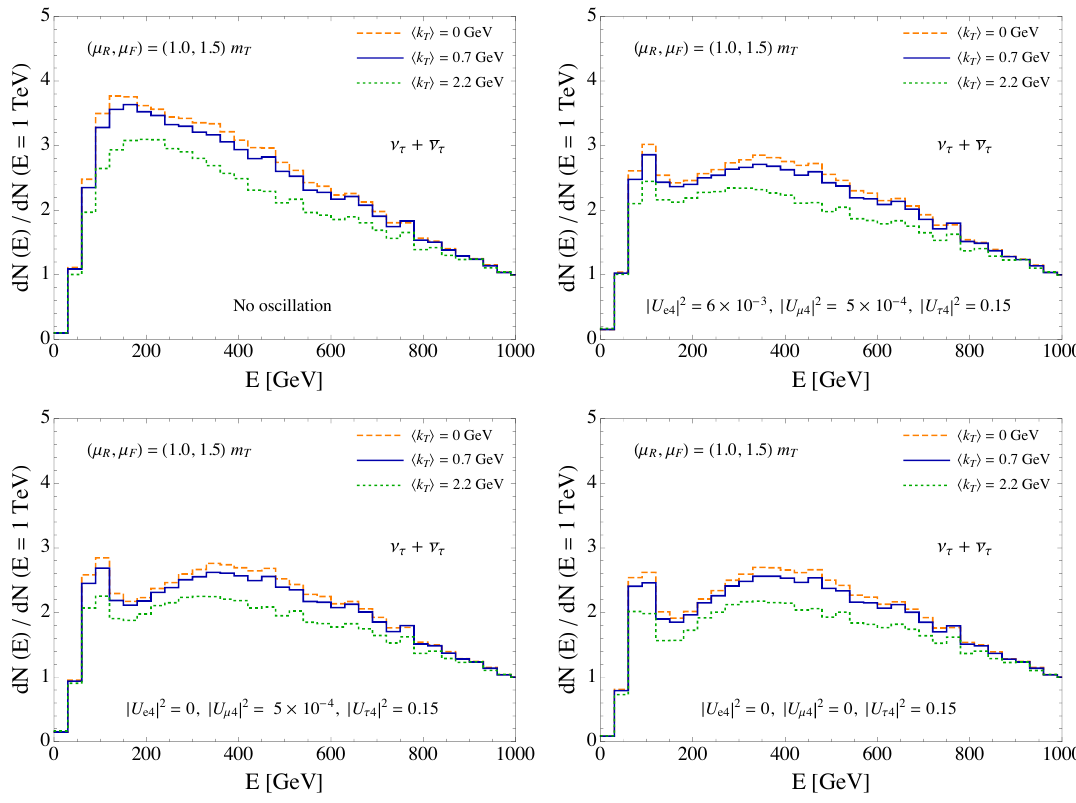
Figure 15 . The same as (cid:12)gure 14, but considering di(cid:11)erent values of h k T i , for our default ( (cid:22) R , (cid:22) F ) scale